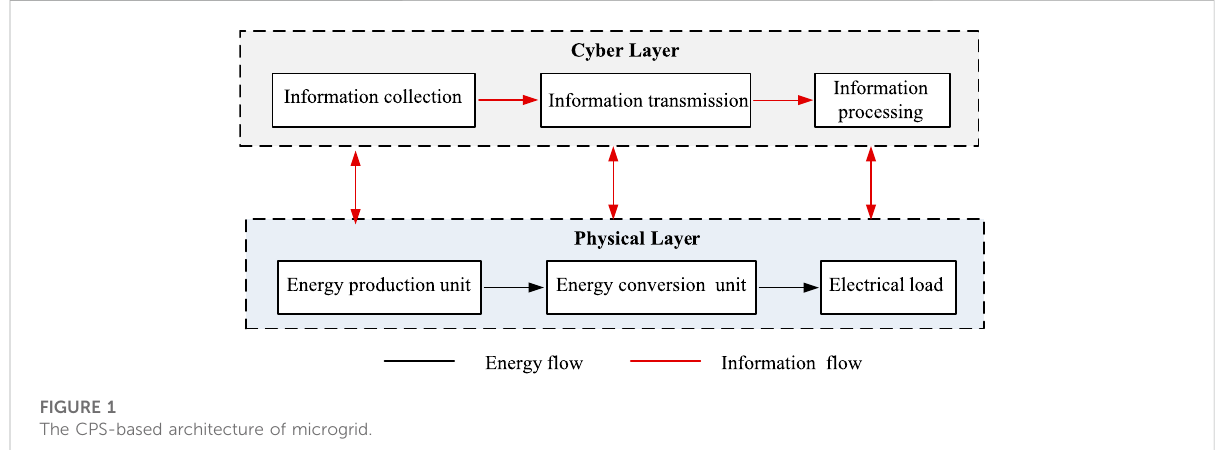
FIGURE 1 The CPS-based architecture of